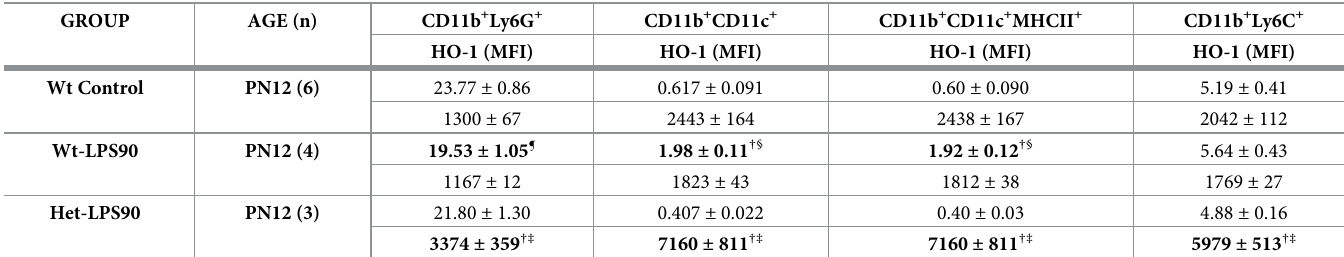
All values are expressed as mean ± SD. Innate immune cell populations expressed as %CD45 + , HO-1 expression in MFI units. ¶ For CD11b + Ly6G + Wt-LPS90 at PN12 compared with Wt Control at PN12 p = 0.0277; † Wt LPS90 PN12 compared with Wt Control PN12 (p < 0.0001) for CD11b + CD11c + and CD11b + CD11c + MHCII + ;